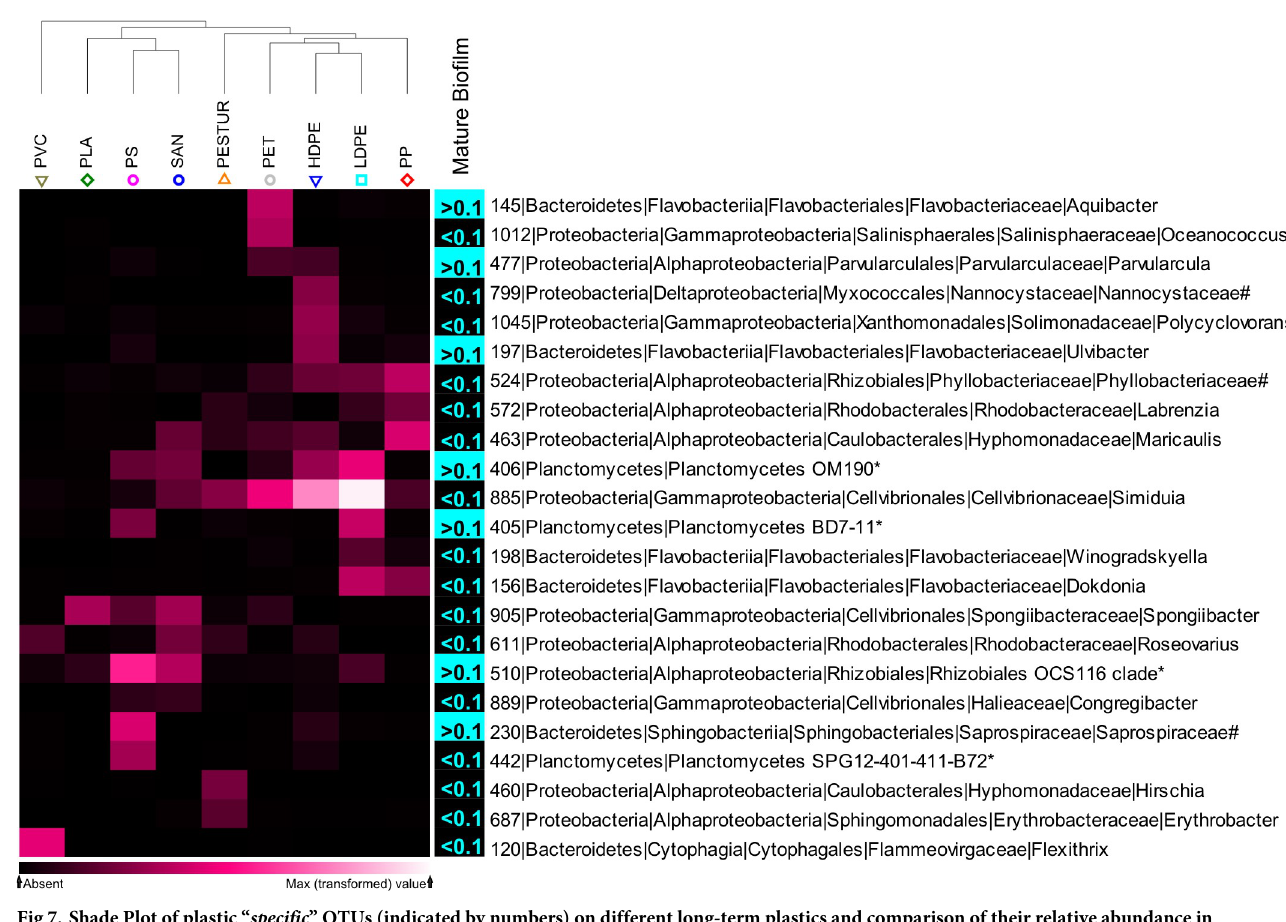
Fig 7. Shade Plot of plastic “ specific ” OTUs (indicated by numbers) on different long-term plastics and comparison of their relative abundance in untreated mature biofilms of the same experimental set up after 15 month. Abundant OTUs (mean relative abundance < 0.1%; n = 50) are indicated in turquoise, rather rare OTUs (mean relative abundance > 0.1%; n = 50) are indicated in black. Shade Plot creation was based on square root transformed relative abundances. OTUs with a mean relative abundance of at least 0.1% in one substrate type (n = 5) were analysed. Displayed are OTUs jointly contributing, with a minimum of 3%, to the total dissimilarity between different plastic groups (SIMPER analysis). OTUs with a mean relative abundance of at least 0.1% present on both, plastics and glass, were rejected. The amount of contribution is indicated by the colour of cells, lighter colours represent higher contributions. A � indicates the term “unclassified”, # indicates the term